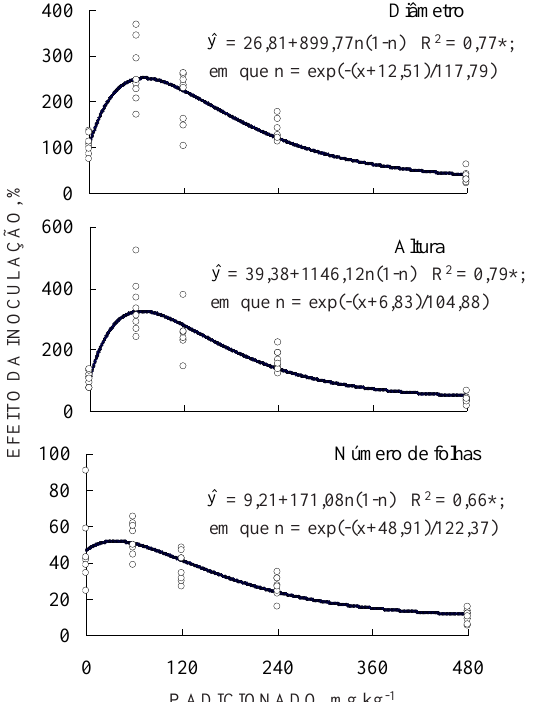
Figura 5. Efeito da inoculação com Glomus macrocarpum para diâmetro médio, mm, (aos 126 dias), altura média, cm, (aos 131 dias) e número médio de folhas (aos 131 dias de idade) de plantas de mamoeiro, considerando o fósforo adicionado ao substrato, fase de vaso. Média de oito repetições. (* significativo a 5